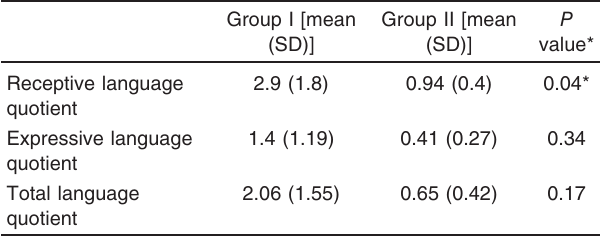
Table 2 Language age quotients